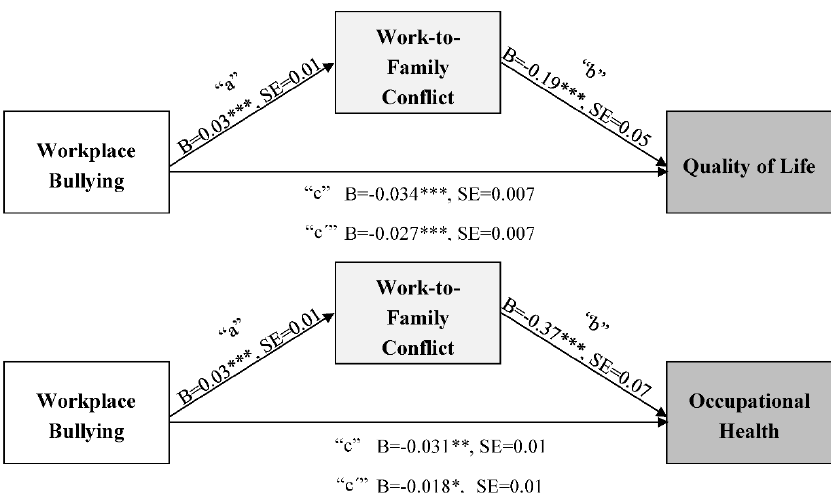
Figure 2. The mediating effects of work-to-family conflict on the links between workplace bullying on well-being outcomes. Note : Analyses adjusted for industry, age, gender, education, and work hours. “a × b” indicates the indirect effect of X on Y through M. “c” indicates the total effect of X on Y. “c’” indicates the direct effect of X on Y after controlling for the effect of M on Y.